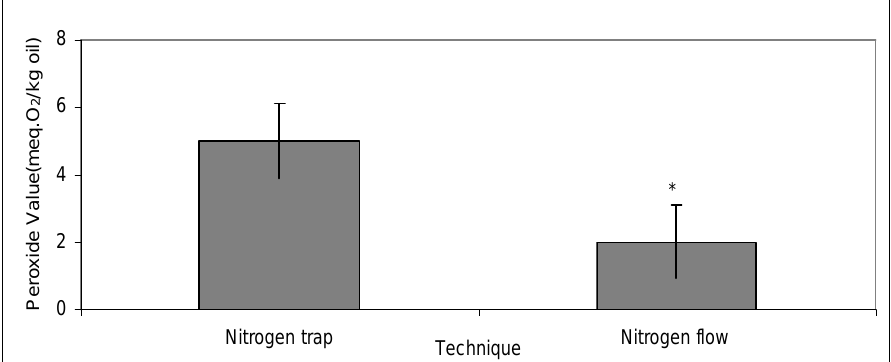
Figure 5. Comparing the vacuum techniques of continuous flow and nitrogen trap in removing